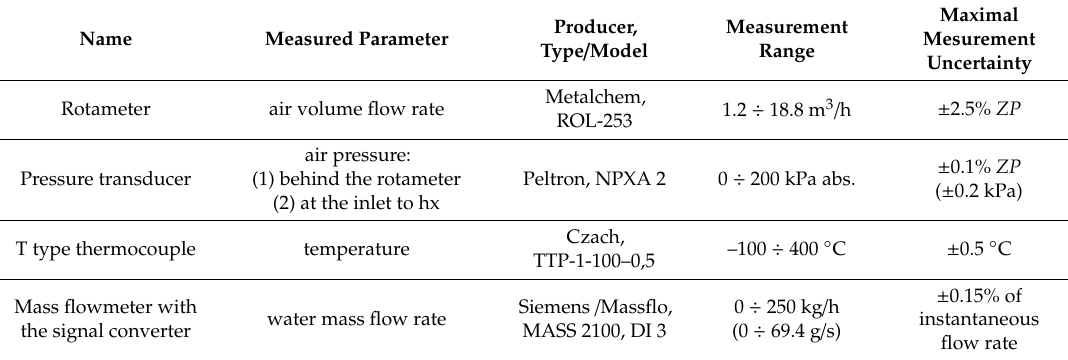
Table 2. List of the measuring sensors and transducers installed in the experimental stand.